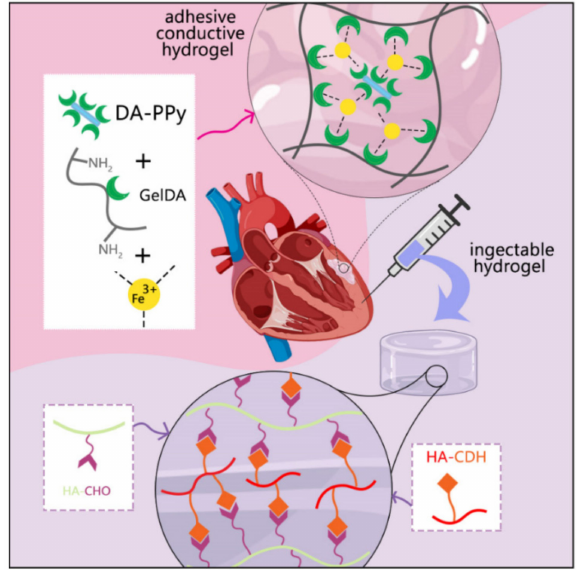
Figure 7. Effect of combination therapy via adhesive hydrogel patch and injectable hydrogel for therapy of MI. The highest quantitative microvascular density and small arterioles were shown in combination hydrogel via the expression of the Willebrand factor (vWF). Adapted with permis- sion